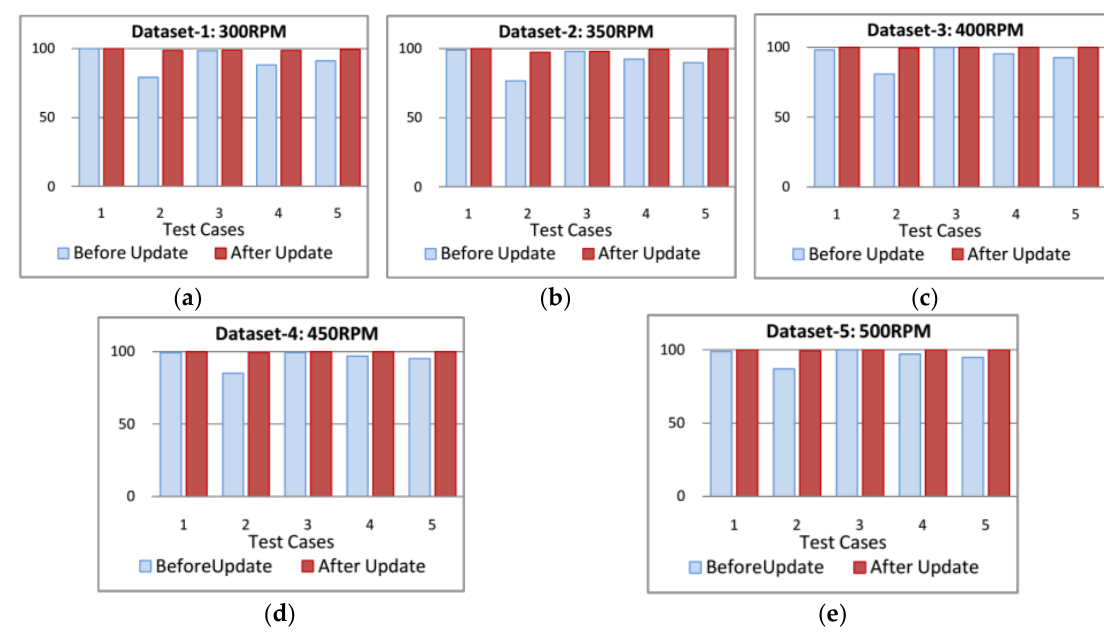
Figure 14. Diagnosis performance improvement for different test cases with different conditional datasets, i.e., ( a ) Dataset-1: 300 RPM, ( b ) Dataset-2: 350 RPM, ( c ) Dataset-3: 400 RPM, ( d ) Dataset-4: 450 RPM, and ( e ) Dataset-5: 500 RPM. The y-axis represents average classification accuracy (ACA) (%).